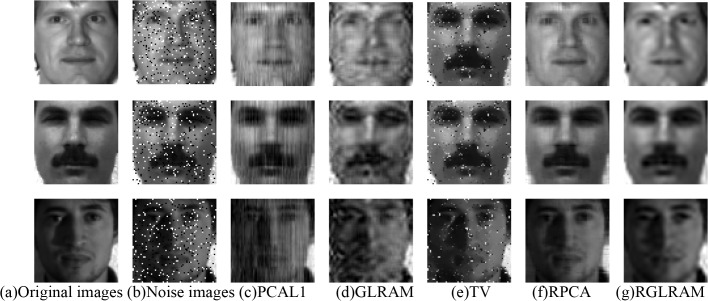
Comparison of low rank recovery and denoising on Yale.
This face dataset is open and can be downloaded freely at
http://vision.ucsd.edu/content/yaleface-database
. It is publicly available for face recognition research, and the consent was not needed.